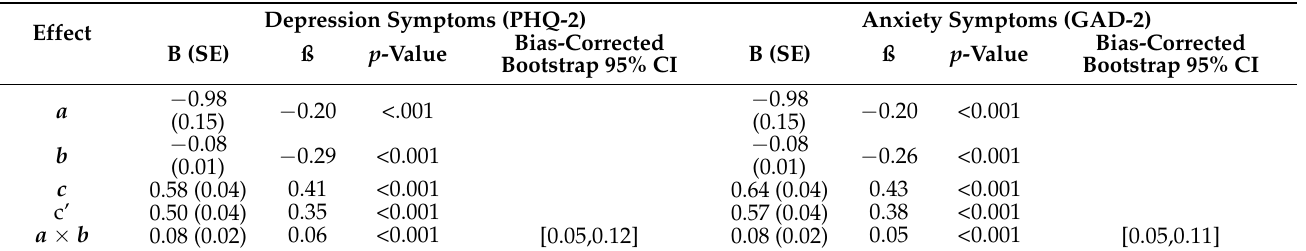
Table 5. Mediating effects of resilience in the relationship between subjective stress burden and mental health symptoms.